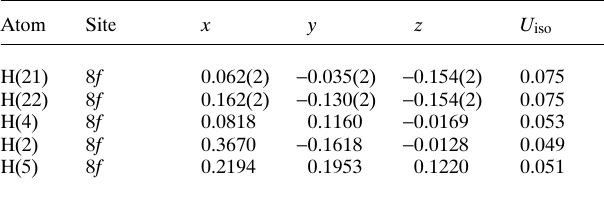
Table 2. Atomic coordinates and displacement parameters (in Å 2 )